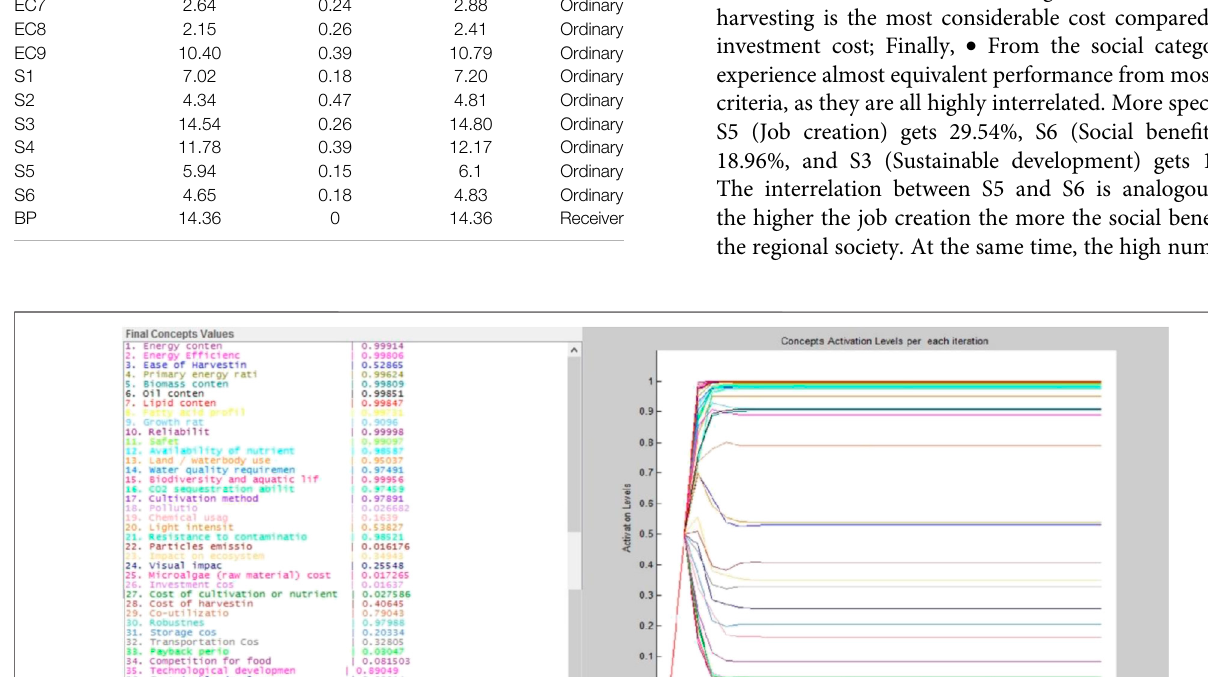
Frontiers in Energy Research |